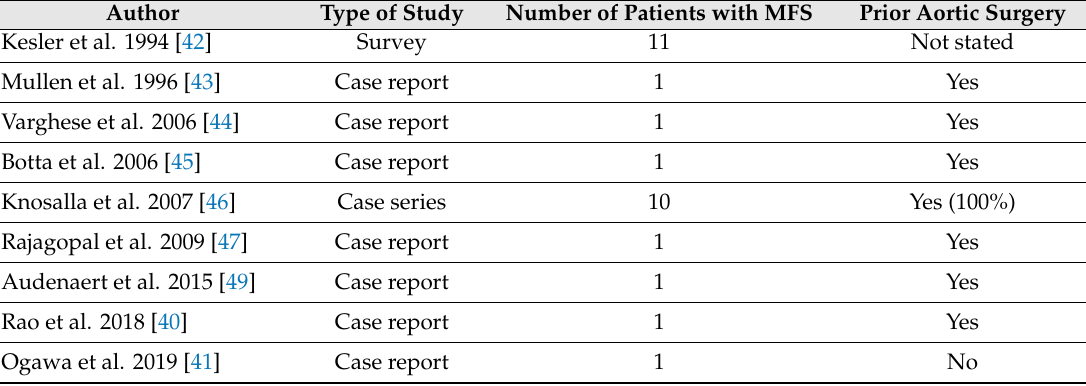
Table 3. Summary of studies reporting end-stage heart failure necessitating heart transplantation in